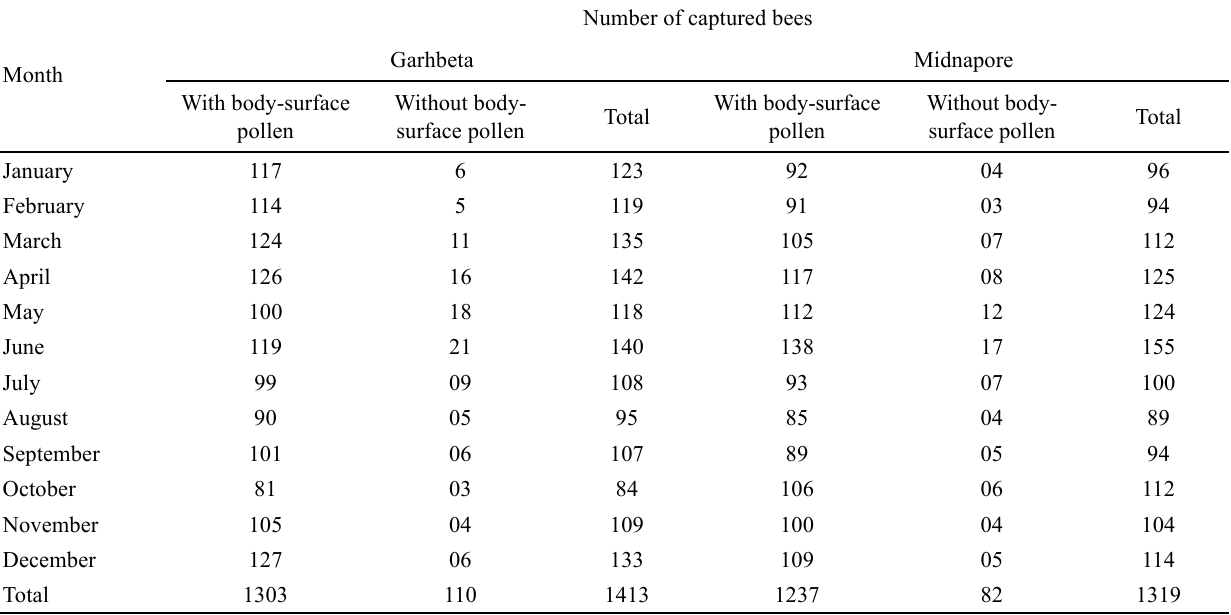
Table 1. Month wise sample size in semi-natural areas of Garhbeta and human-altered areas of Midnapore town in West